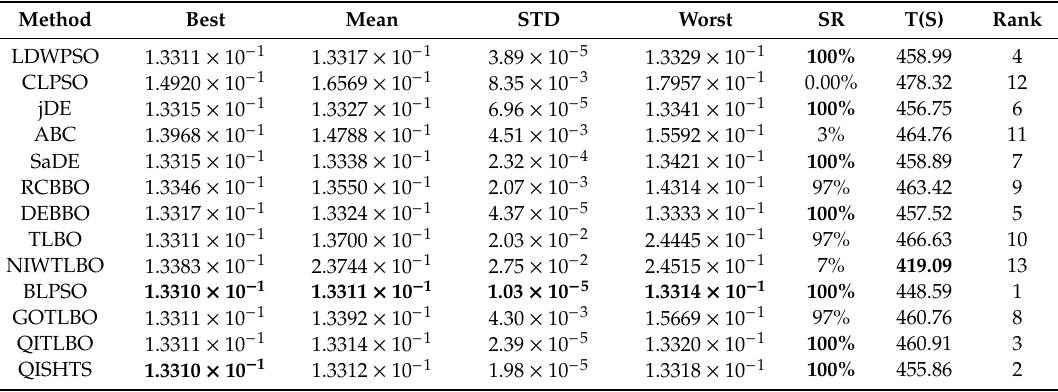
Table 9. Results of the compared algorithms for the multi-modal CSTR